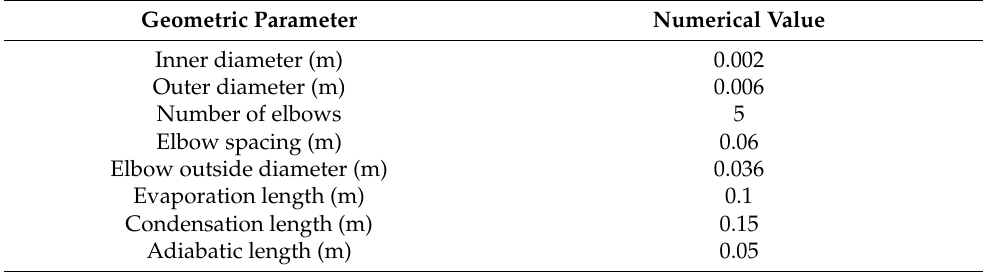
Table 1. Detailed dimensions of the